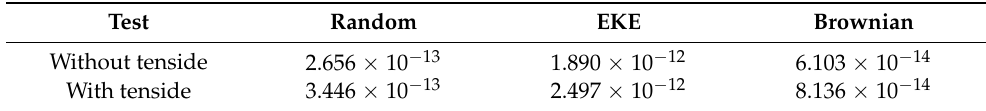
Table 2. Aggregation rate constants β 0 obtained using different